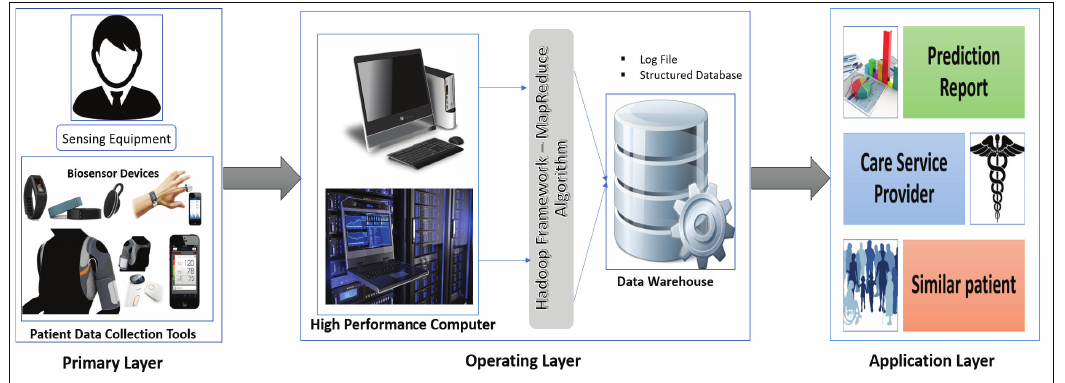
Figure 1. Three phases of interactive healthcare: Primary layer, Operating layer, and Application